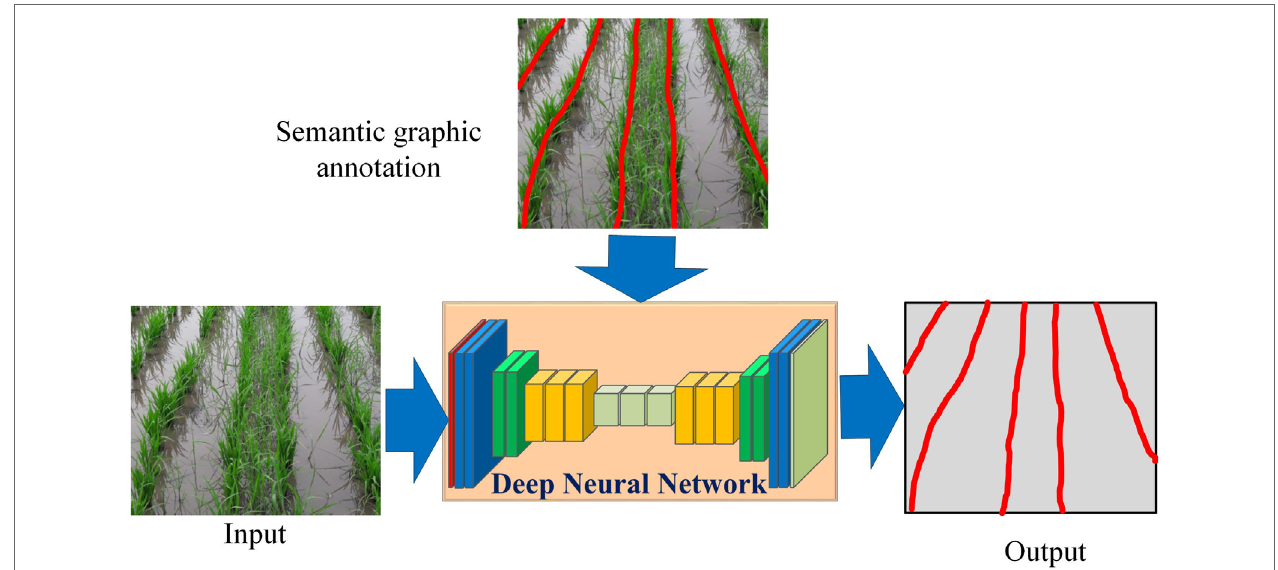
FIGURE 1 | The proposed approach of training deep neural networks to learn the concept of crop line using semantic graphics.